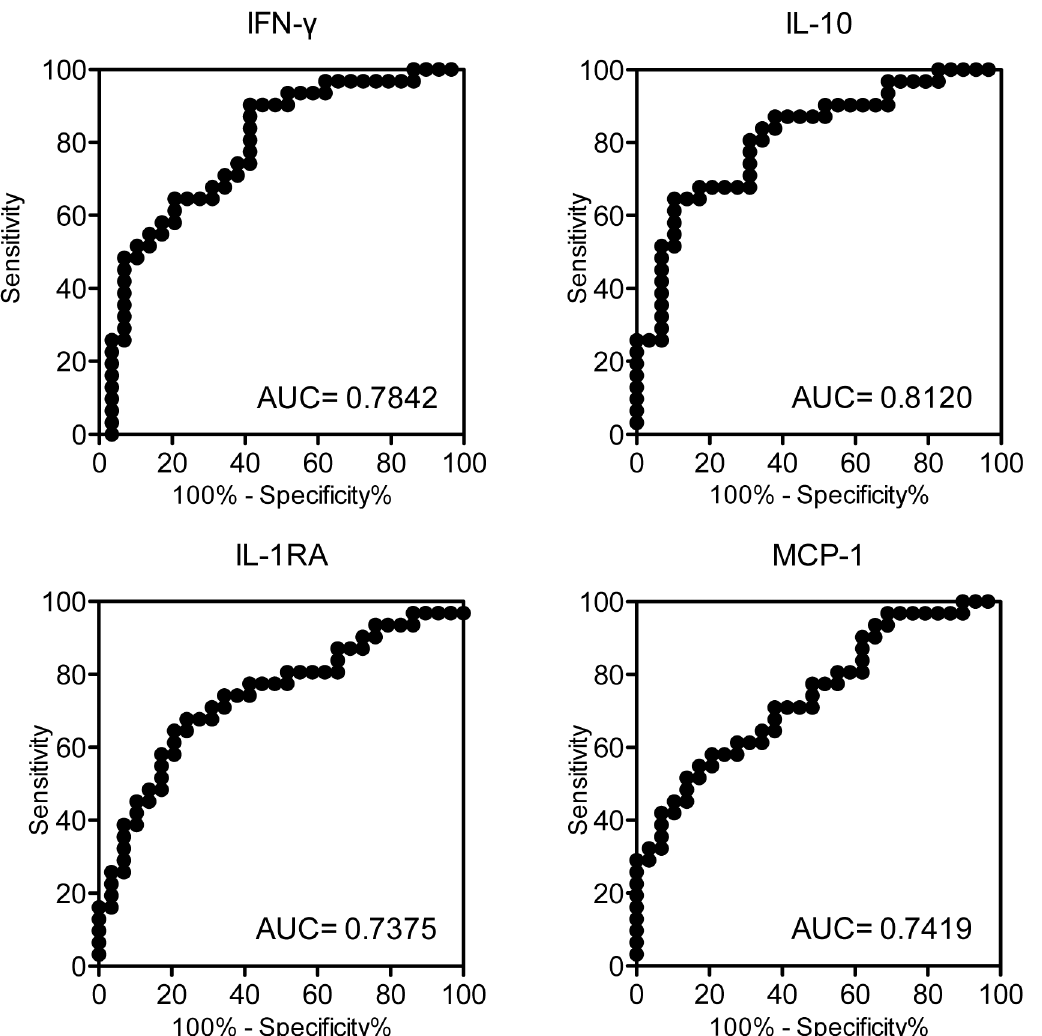
Fig 2. Major ROC curves comparing the diagnostic accuracy of cytokines in TBAg – Nil supernatants for differentiating active TB from LTBI. AUCs for each cytokine are shown in the